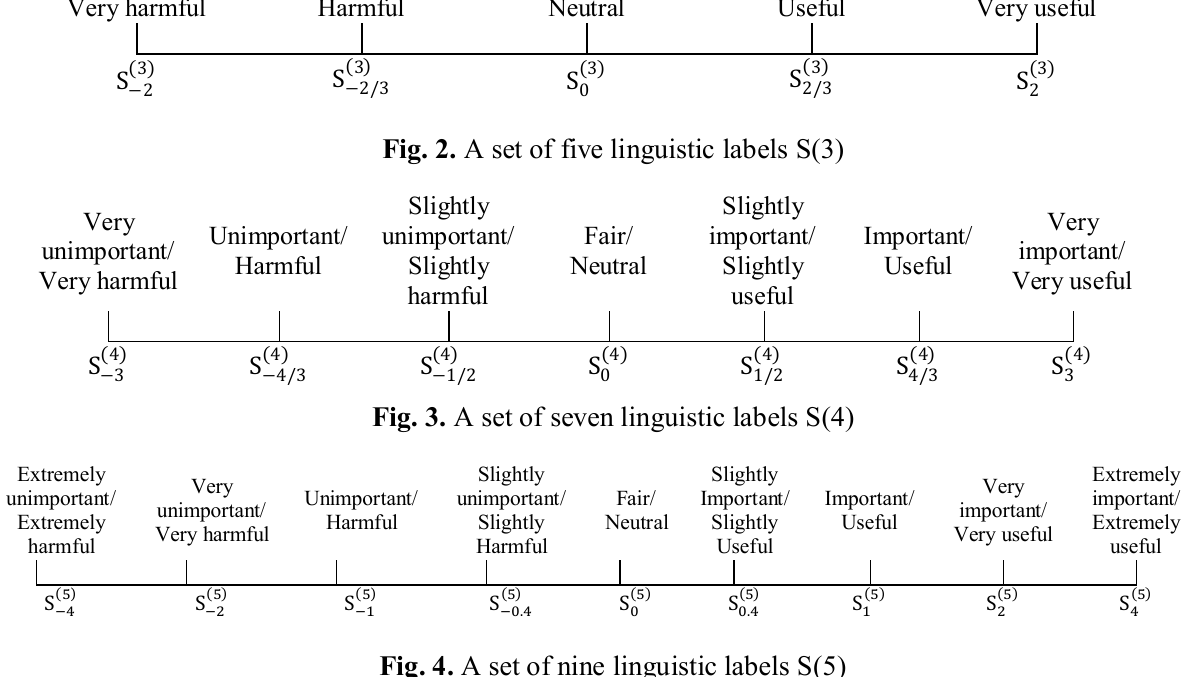
Fig. 4. A set of nine linguistic labels